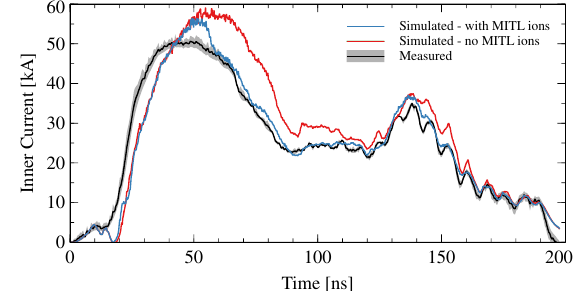
FIG. 8. Comparison of inner currents with and without MITL ions.